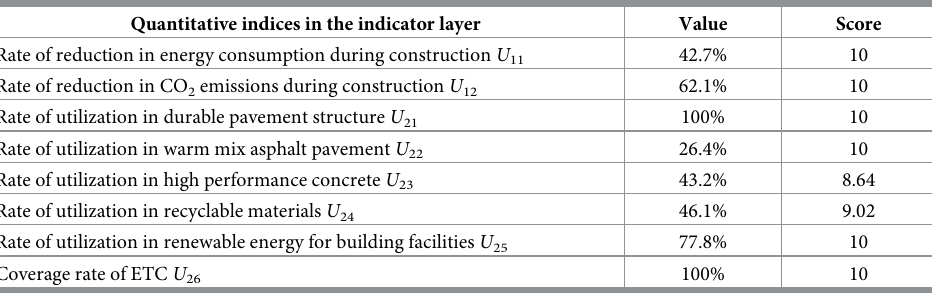
Table 6. Completion performance of quantitative indices.